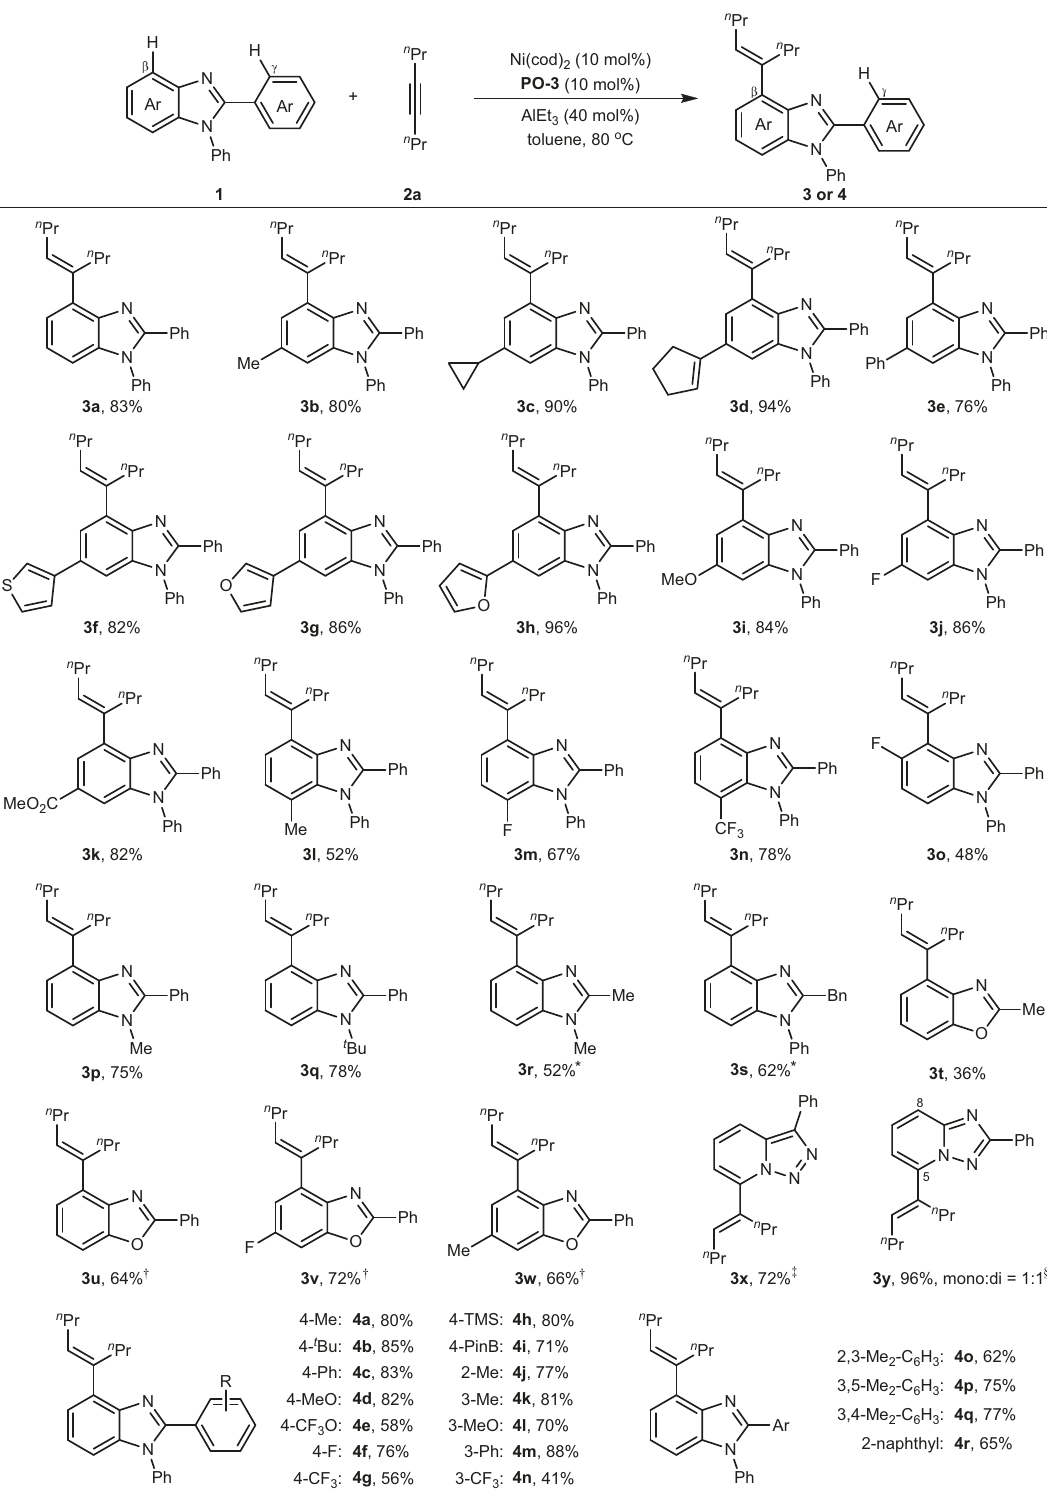
Fig. 3 Scope of benzimidazoles and analogs. Reaction conditions: 1 (0.4 mmol), 2a (0.8 mmol), AlEt 3 (1 mol/L in hexane, 0.16 mmol), toluene (0.8 mL) under N 2 for 12 h. Yield of isolated products. *100 °C, AlMe 3 (1 mol/L in hexane, 0.32 mmol). † PO-3 was replaced by bulkier PO-6 (see the structure in the SI). ‡ 30 °C. § mono refers to C5-alkenylated product and di refers to C5 and C8-dialkenylated product. n Pr = n